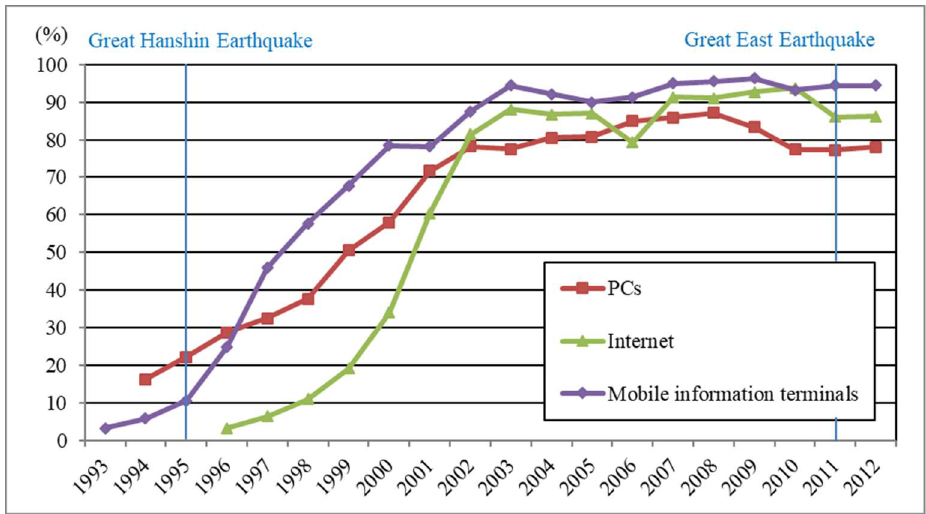
Fig. 1. Change of means of information communication after the Great Hanshin Earthquake (1995). Note) Cabinet Office (2013) Consumer Confidence Survey in